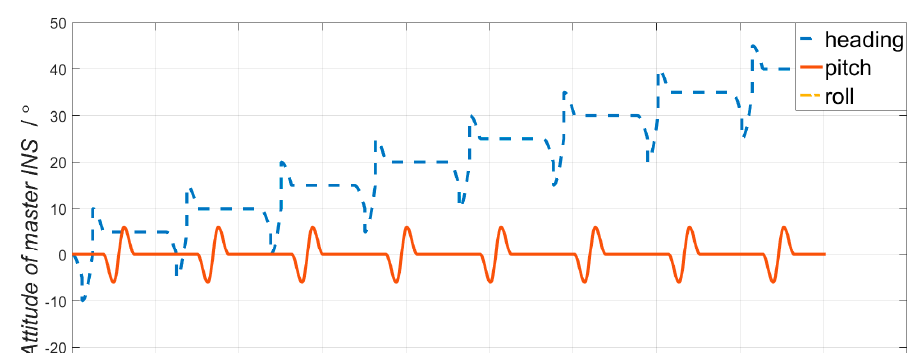
Figure 6. The flight trajectory.